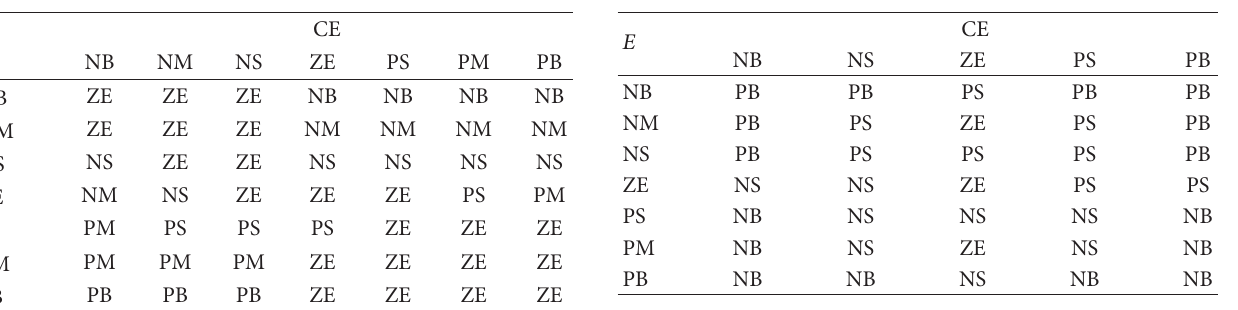
Table 5: The forty-nine fuzzy rules of the fourth fuzzy subset (S4). Table 6: The thirty-five fuzzy rules of the fifth fuzzy subset